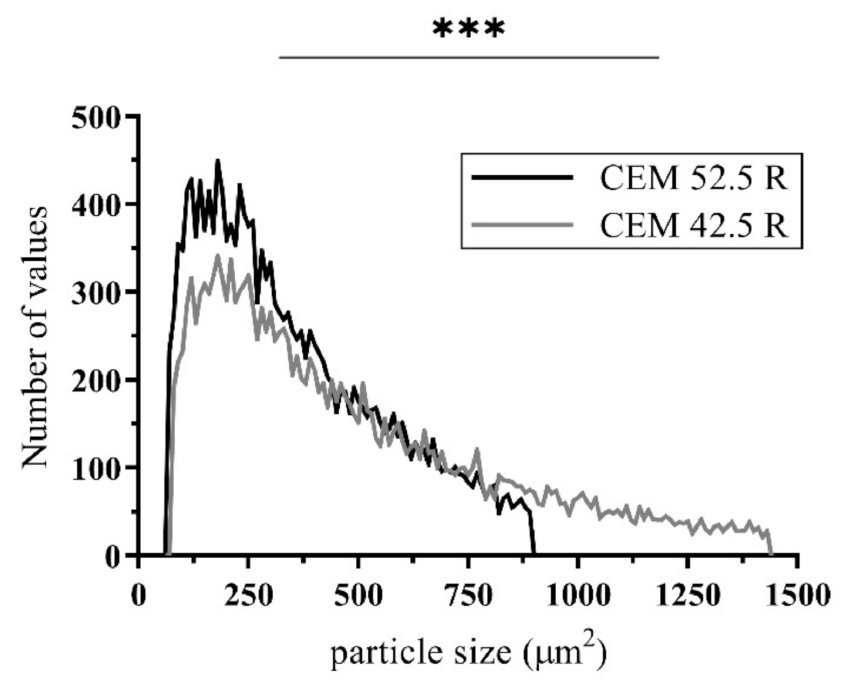
Figure 10. Comparison of size and distribution of cement particles in cement suspensions. A Stu- dent’s t test was used for statistical testing; *** p <